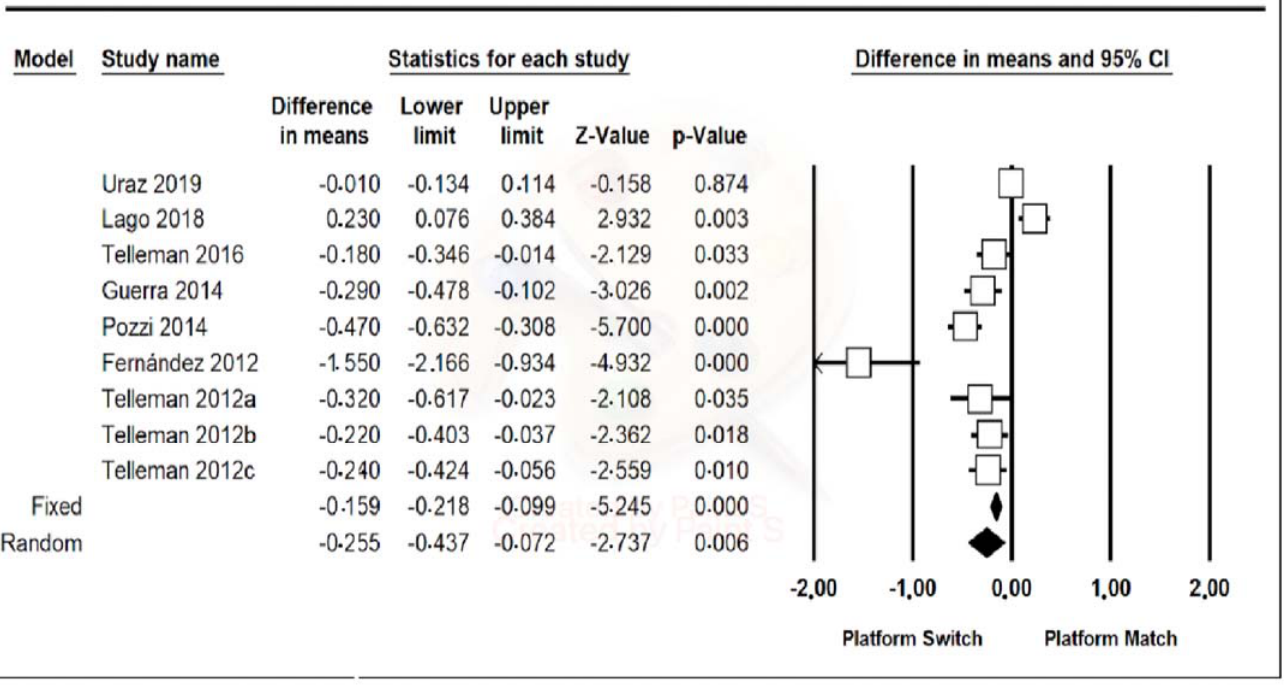
Figure 2. A forest plot of peri-implant bone level maintenance.